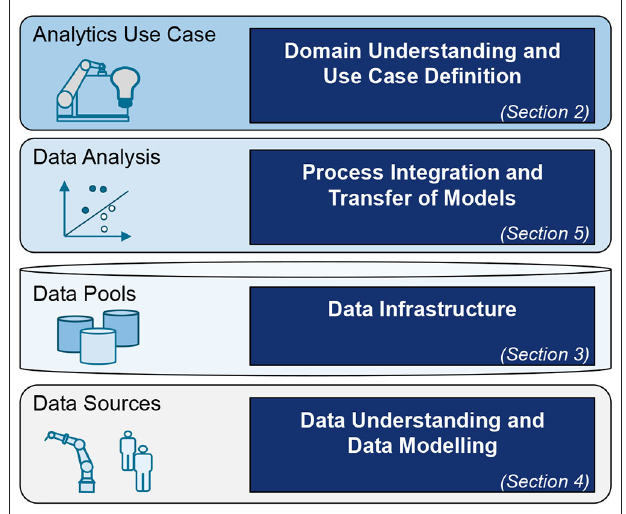
FIGURE 2 | Integration of process steps into the layer model for development of data analytics applications and overview of the best practice contributions in this